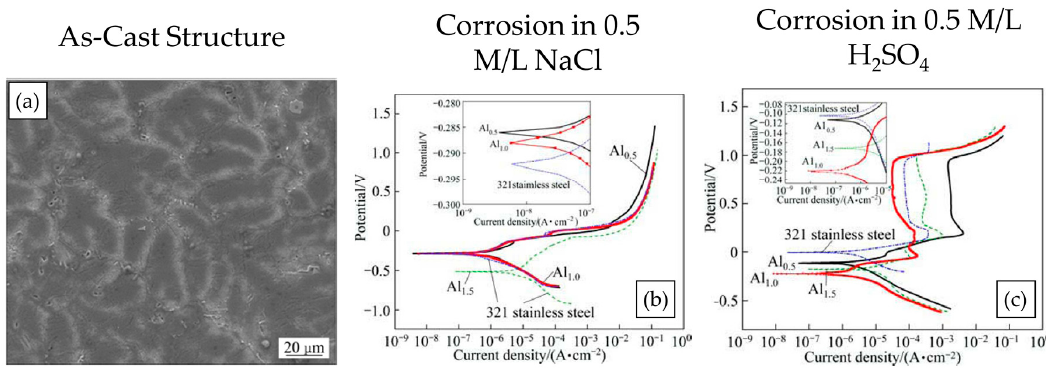
Figure 12. ( a ) As-cast microstructure of Al 1.5 CoCrCu 0.5 FeNi CCA alloy, potentiodynamic polarization plots of Al x CoCrCu 0.5 FeNi ( x = 0.5, 1.0, and 1.5) in ( b ) 0.5 M/L NaCl, and ( c ) 0.5 M/L H 2 SO 4 [41]. The potentiograms show better corrosion resistance of the alloys as compared to SS321 alloy (reprinted with permission from Elsevier).